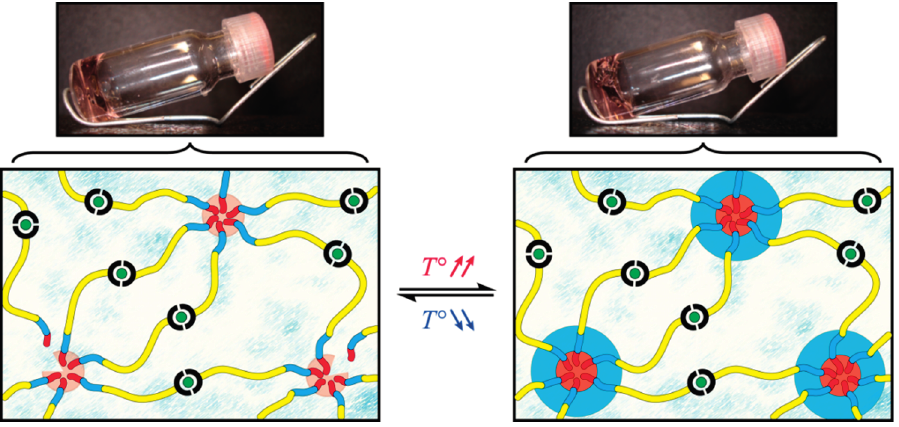
Figure 6. Schematic representations and illustrations of the thermo-response of the PS- b -PNIPAAm- b -PDMAEMA-tpy triblock copolymer